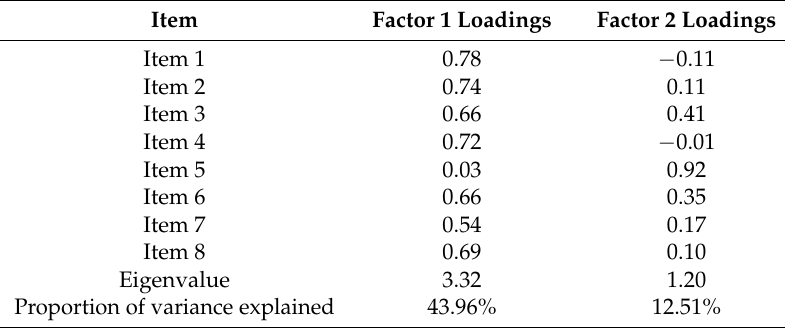
Table 2. Validity measurement of the